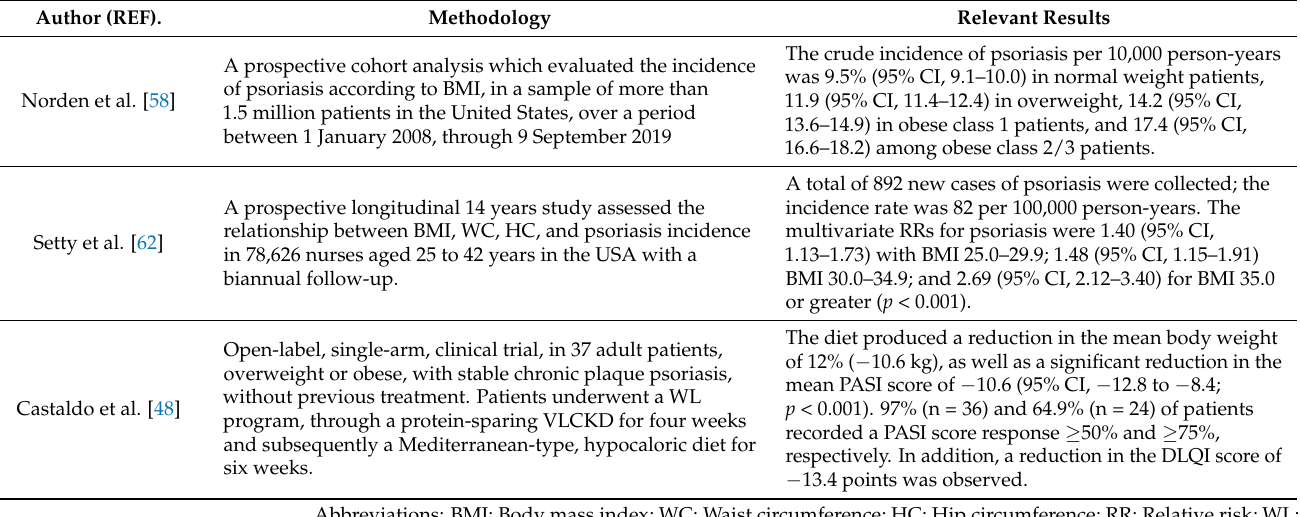
Table 1. Summary of clinical evidence correlating the anthropometric index to